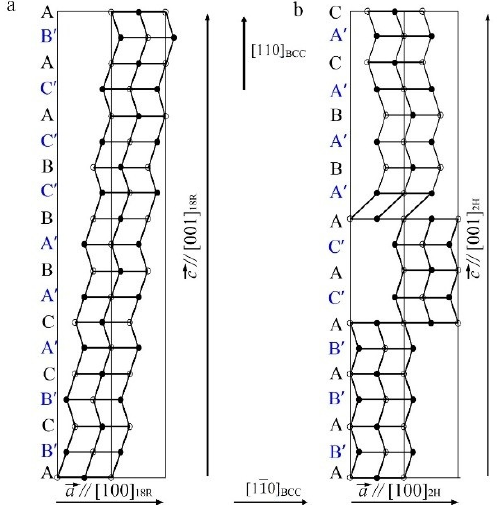
Figure 16. Schemes of crystal lattice rearrangement of martensite: ( a ) D0 3 → 18R and ( b ) D0 3 → 2 H [62]. Table 4. Critical temperatures of the start (M s , A s ) and finish (M f , A f ) of the TMT in the